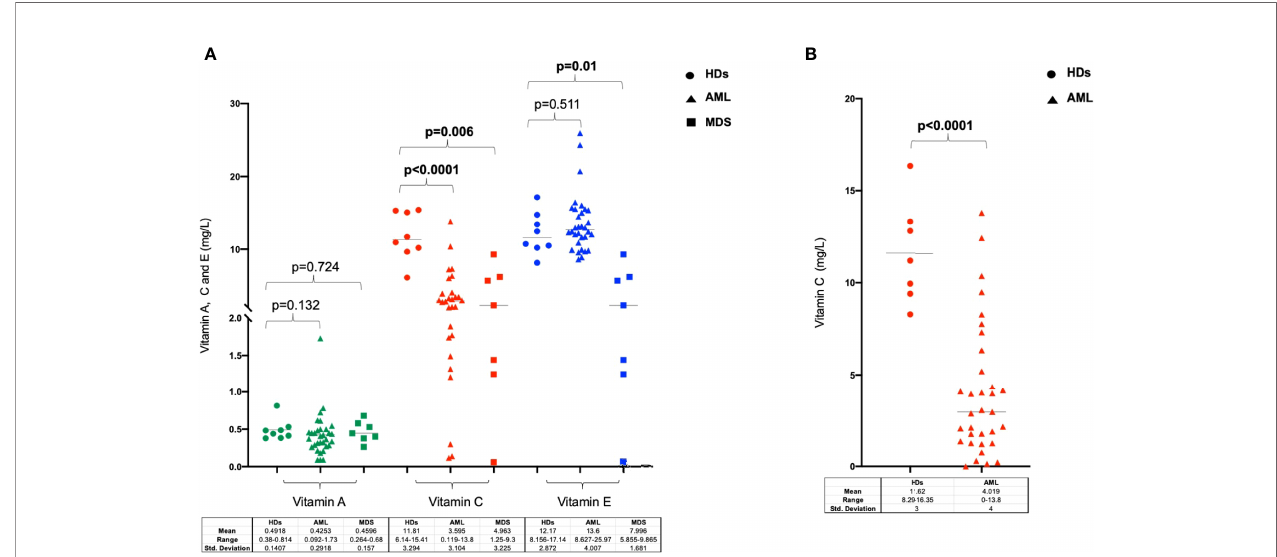
FIGURE 1 | Levels of Vitamin A, C and E in patients with myeloid neoplasms and in healthy donors. (A) Vitamin A, C and E concentration analyzed in serum or plasma in healthy individuals, AML and MDS patients at diseases diagnosis. (B) Analysis of Vitamin C plasma levels in a validation cohort of healthy donors and AML patients at disease onset. HDs, healthy donors.